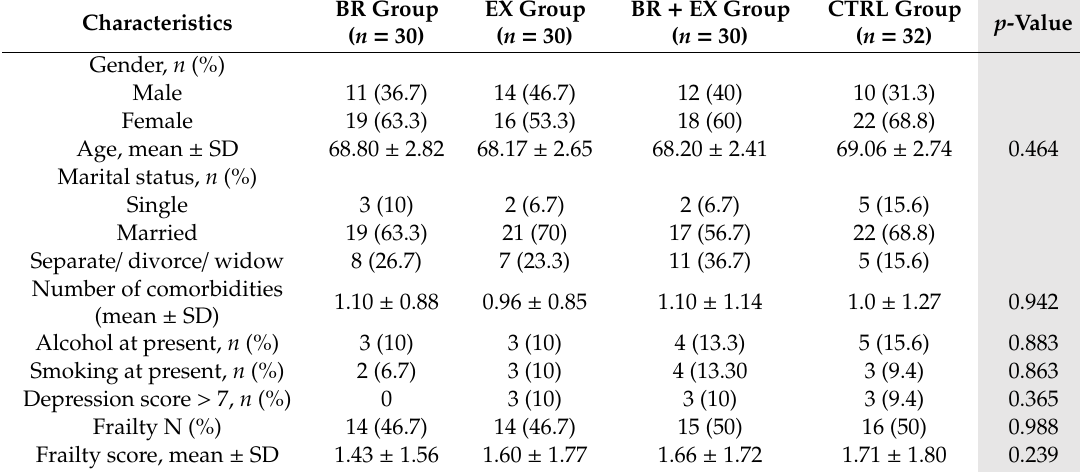
Table 2. Baseline (T0) descriptive data of sociodemographic characteristics and health profiles of